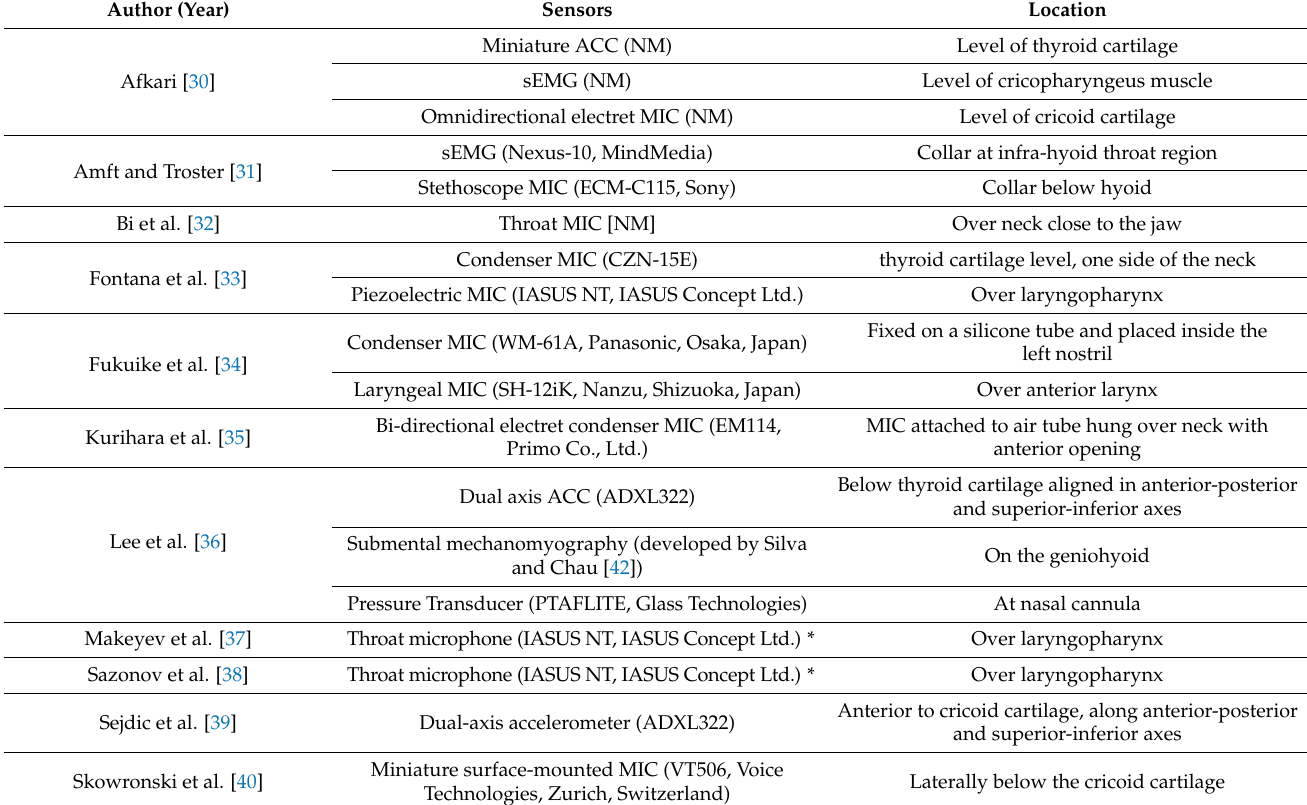
Table 1. Instrument setting and location in the reviewed